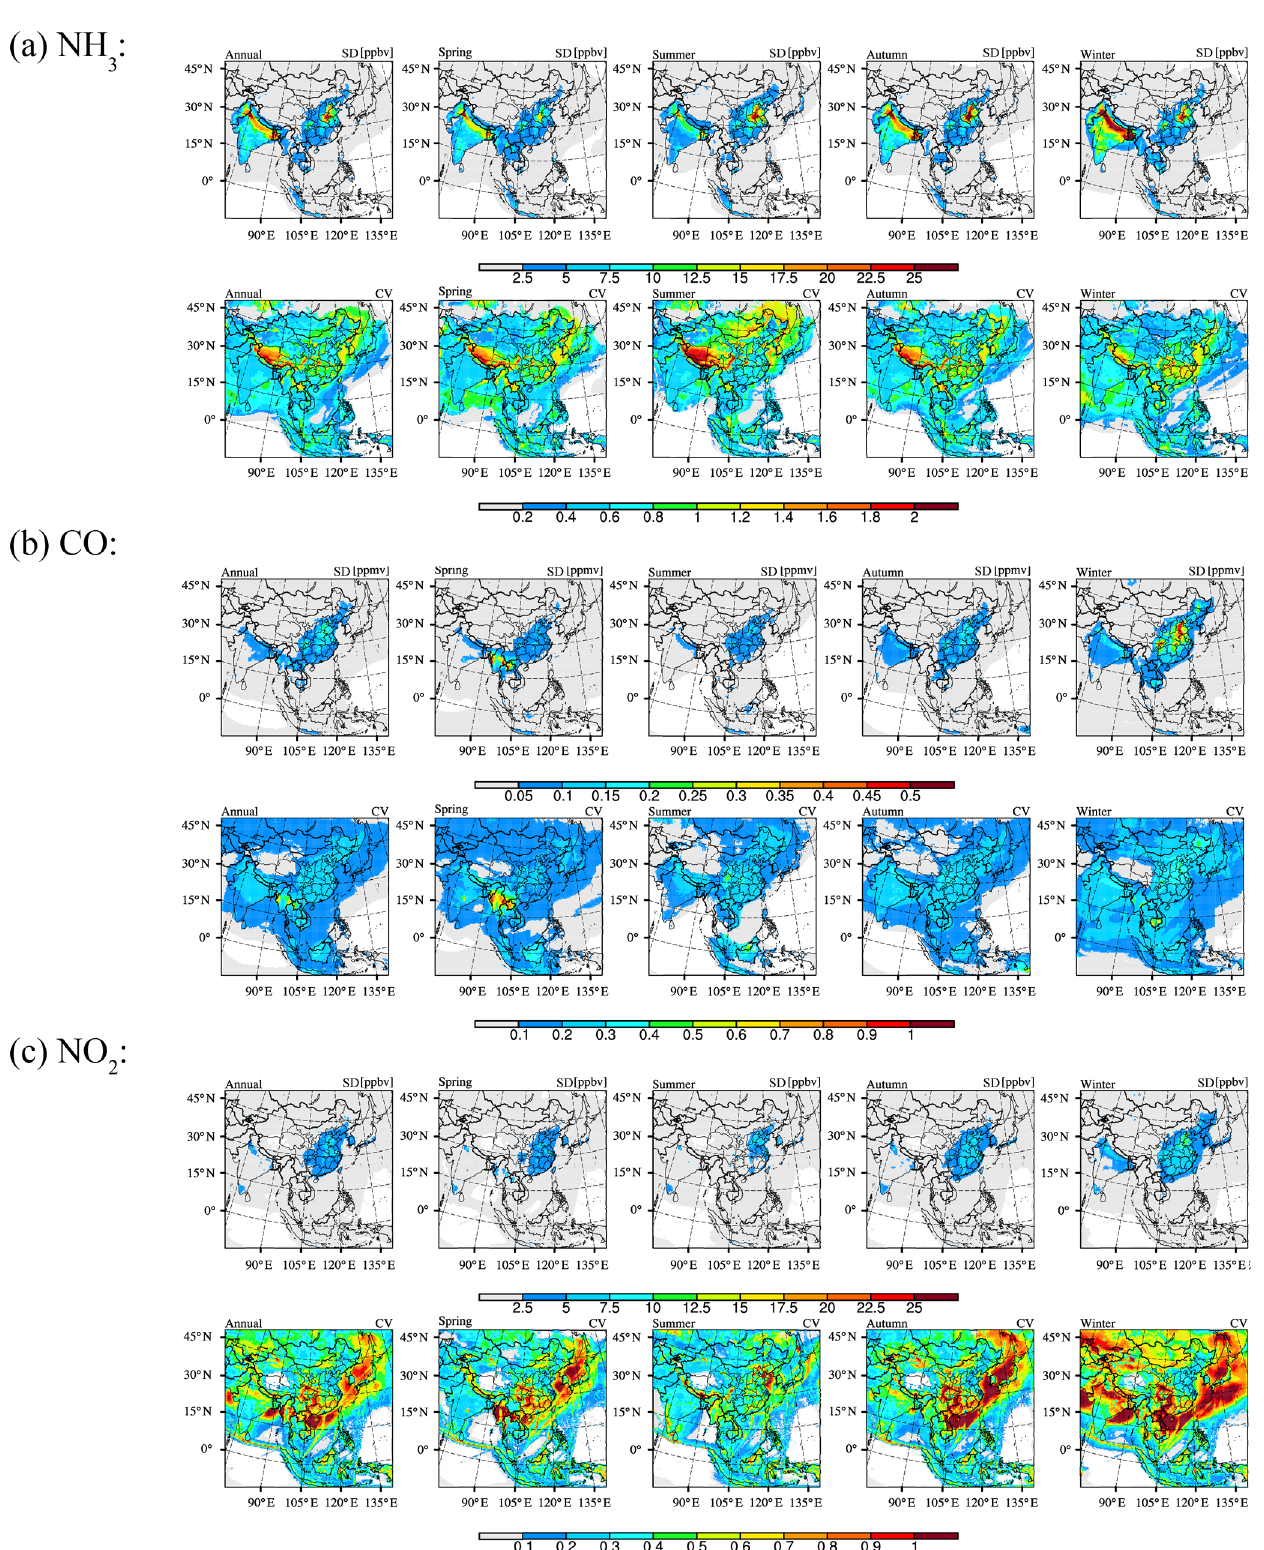
Figure 9. Spatial distribution of the standard deviation of (a) NH 3 , (b) CO and (c) NO 2 multi-model predictions from MICS-Asia III, as well as the corresponding distribution of CV on the annual and seasonal